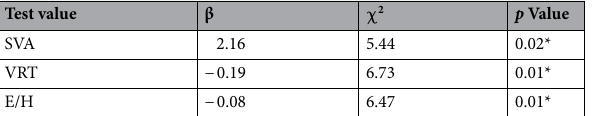
Table 4. Tests of significant differences in sports vision tests in the three-test model. Notes: Model including only tests selected using the stepwise method. Abbreviations: SVA: static visual acuity, VRT: visual reaction time, E/H: eye hand coordination.